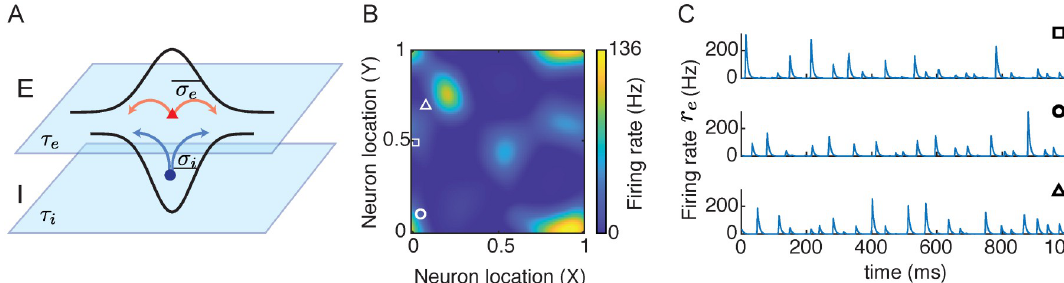
Fig 1. Irregular spatiotemporal dynamics in spatially distributed networks. A . Model schematic of recurrently coupled excitatory (E) and inhibitory (I) neurons. Neurons from each population are equally spaced on a two dimensional sheet, [0, 1] × [0, 1], with distance- dependent connectivity weights. B . A snapshot of the firing rates of excitatory neurons. C . Three examples of the time courses of firing rates of neurons at different locations. The square, circle and triangle in panel B denote the spatial location of each neuron.